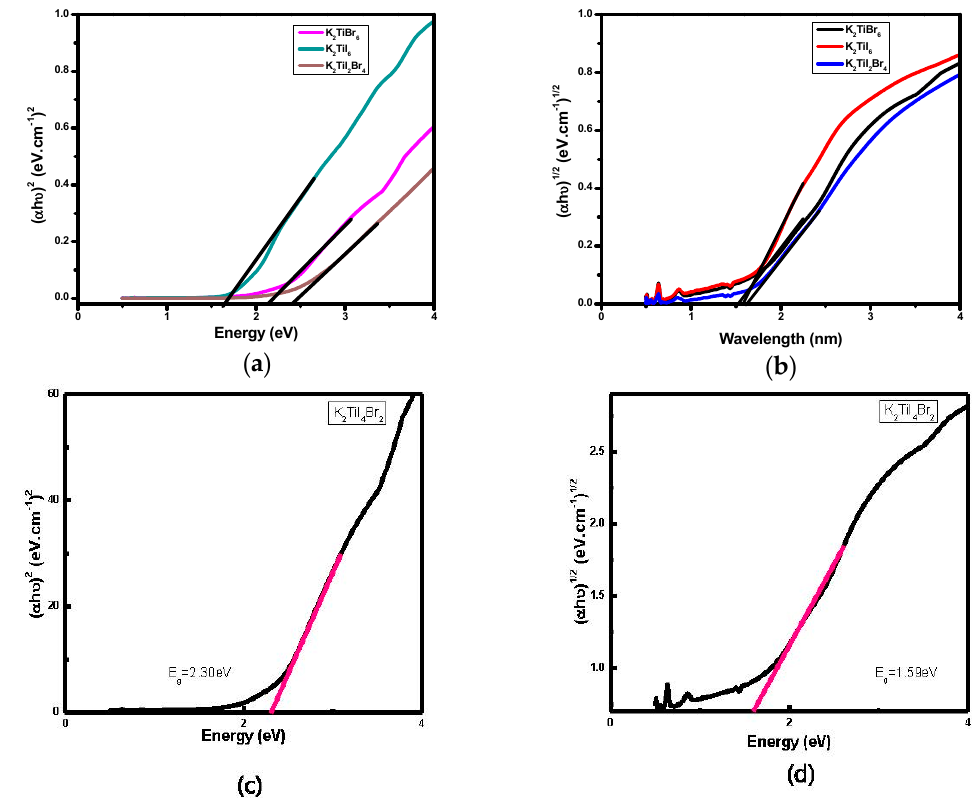
Figure 4. Tauc plot for ( a ) direct bandgap of K 2 TiBr 6 , K 2 TiI 6 and K 2 TiI 2 Br 4 and ( b ) indirect bandgap of K 2 TiBr 6 , K 2 TiI 6 and K 2 TiI 2 Br 4 . ( c ) Direct bandgap of K 2 TiI 4 Br 2 and ( d ) indirect bandgap of K 2 TiI 4 Br 2 . in the visible region and red shifted in the order K 2 TiI 2 Br 4 < K 2 TiBr 6 < K 2 TiI 6 . PL intensity of mixed halide perovskite is less compared to bromide and iodide perovskites. Transition bandgap calculated from Figure 5 is similar to the bandgap intercepted from Tauc plot. This shows low defect density in all these perovskites. The FWHM of K 2 TiI 6 is 7.15 nm, while K 2 TiBr 6 and K 2 TiI 2 Br 4 have values 1.06 nm and 16.76 nm respectively. PL spectra of CH 3 NH 3 PbI 3 recorded broad high intensity peak at ~786 nm corresponding to its reported bandgap value (~1.60 eV) [37].